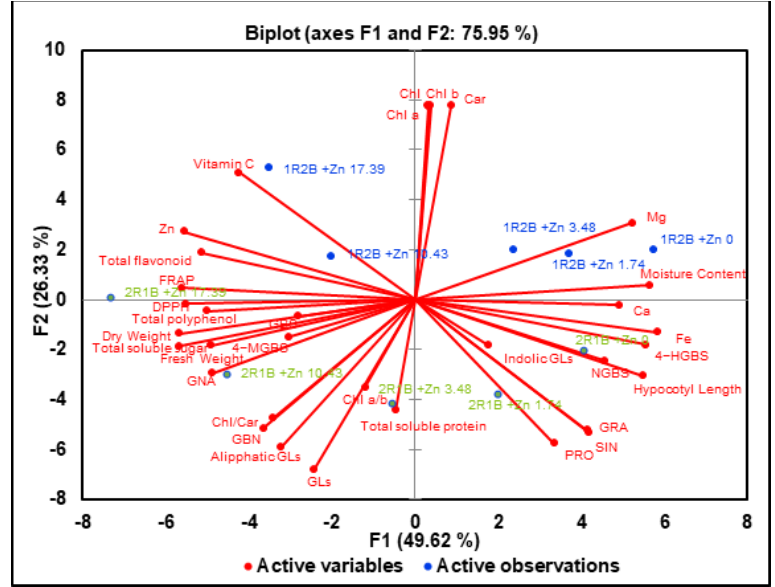
Figure 8. Principal component analysis of flowering Chinese cabbage sprouts (FCCS) grown at combination of Zn concentration and R-B ratio (ratios of red and blue light).